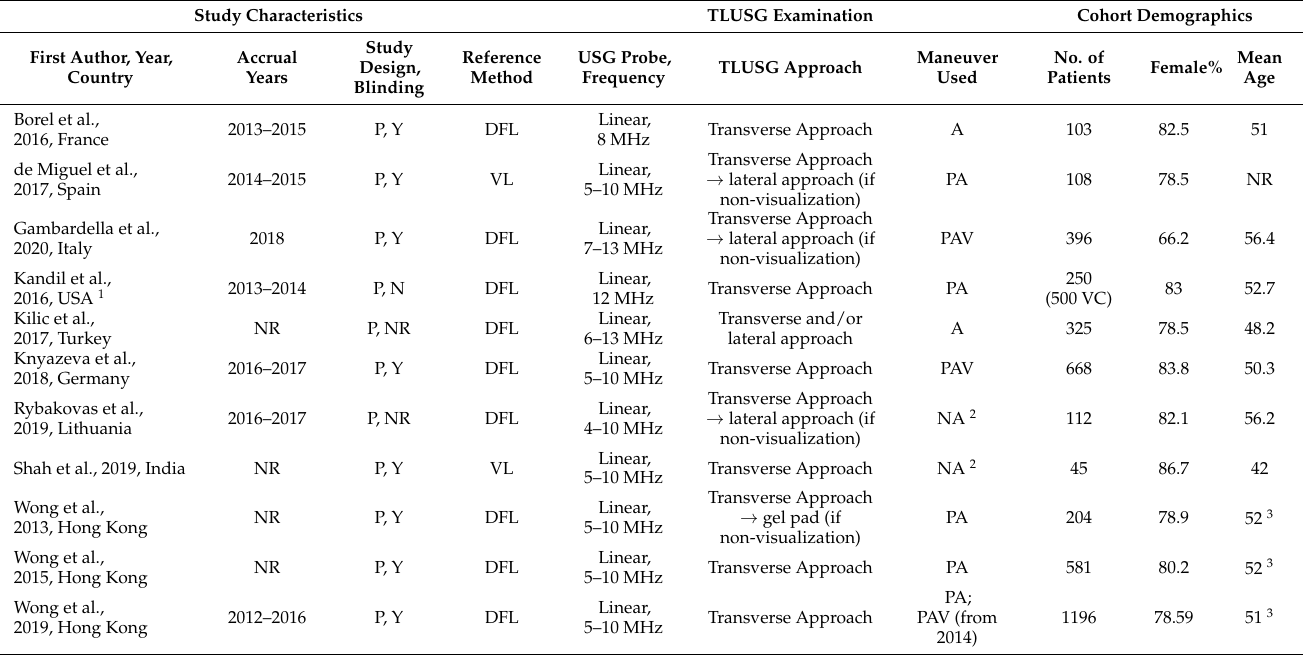
Table 1. Characteristics of studies assessing TLUSG in terms of operative period.